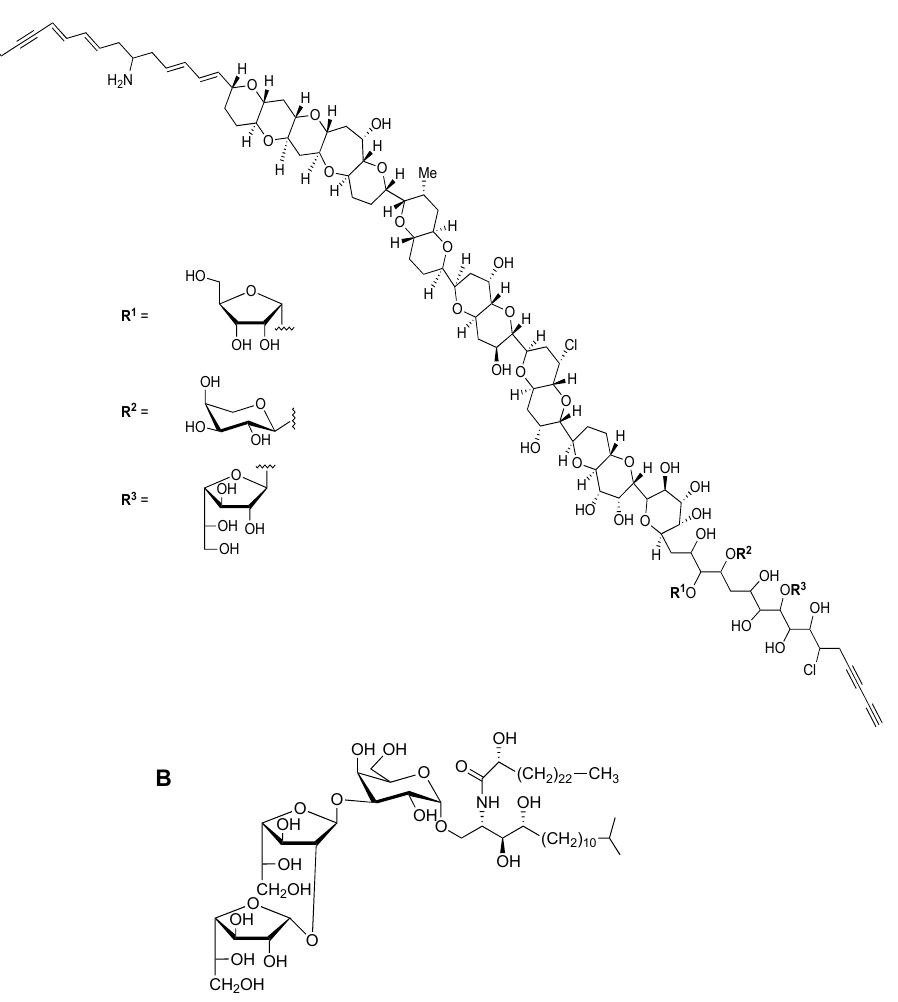
Figure 4. Chemical structures of Gal f -containing glycoconjugates. ( A ) The structure of toxin prymnesin-1, produced by Prymnesiou parvum . ( B ) The structure of agelagalastatin, glycosphingolipid produced by Agelas sp . [4].